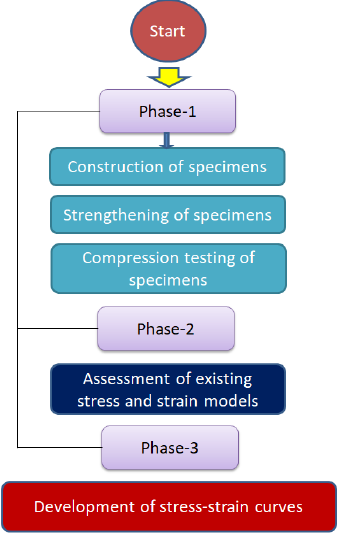
Figure 1. Research flow chart.